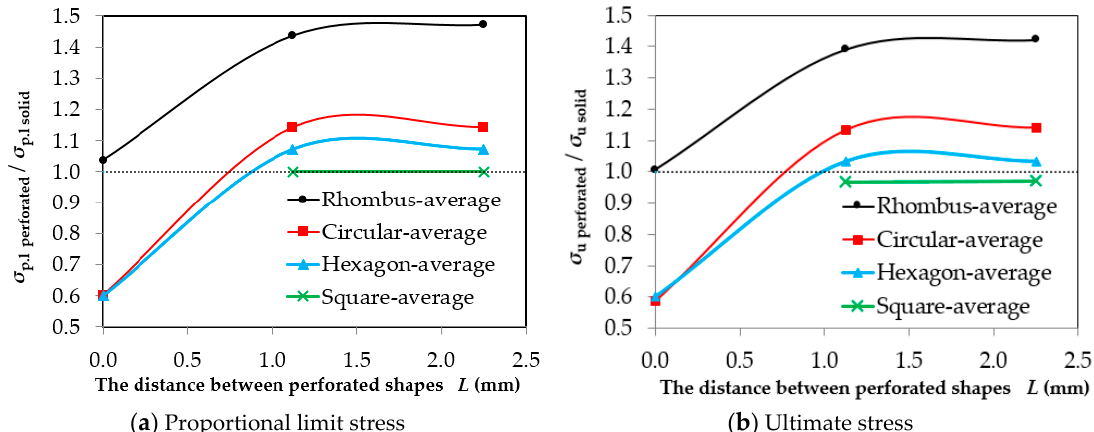
Figure 12. Relation between the ratio of perforated steel sheets stresses to control solid steel sheets and the influence of the distance between perforated shapes.